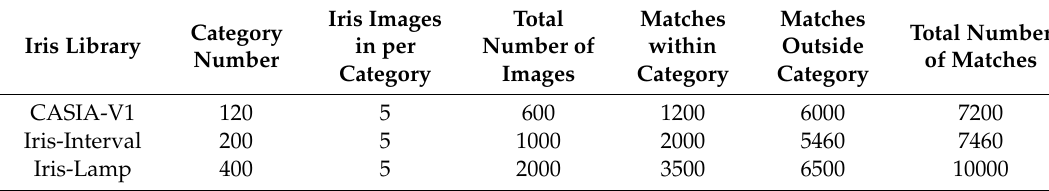
Table 7. Number of comparisons in comprehensive experiment.